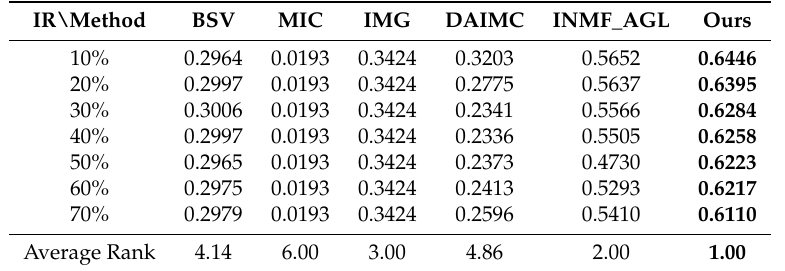
Table 3. ACCs and average ranks on BUAA under different incomplete ratios. Bold numbers denote the best result.